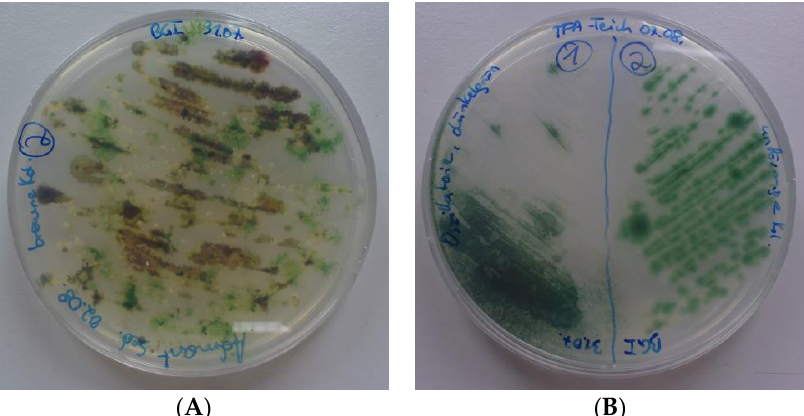
Figure 4. Fractionated streaks of mixed cyanobacteria samples after cycloheximide treatment taken from ( A ) Admont (AUT) and ( B ) Tulln, IFA-Teich (AUT).